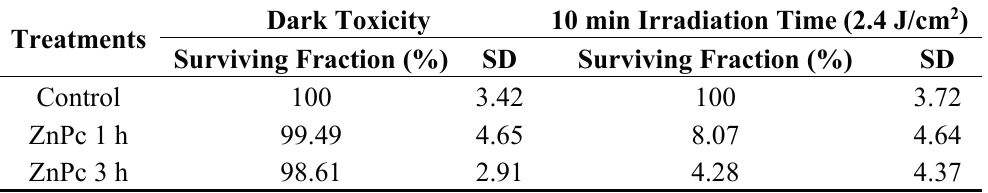
Table 1. HeLa cell survival after different treatments, with and without irradiation. Data correspond to the mean values ± standard deviation (SD) from six different